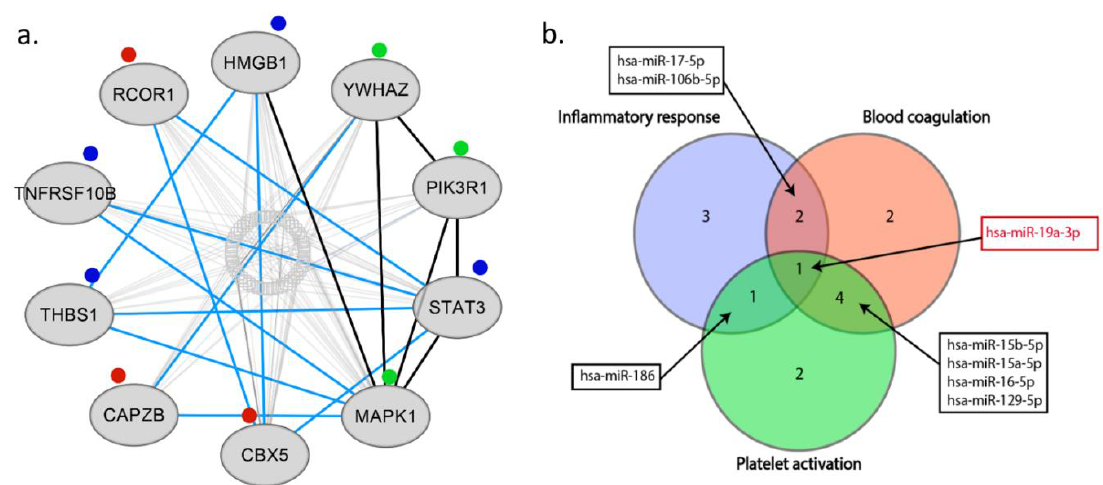
Figure 4. miRNA-target gene networks based on platelet activation. ( a ) Platelet activation-network sorted by the degree of connections, ( b ) Platelet activation-interaction network. The rectangles indicate the stroke type miRNAs, the ellipses indicate target genes. Red and green marks represent specific GO process-blood coagulation and platelet activation, respectively. LA, large artery stroke; SA, small artery stroke; UDN, stroke due to undetermined cause; CE, cardioembolic stroke; NaN, no data; ODE, other determined etiology; UN, determined cause.